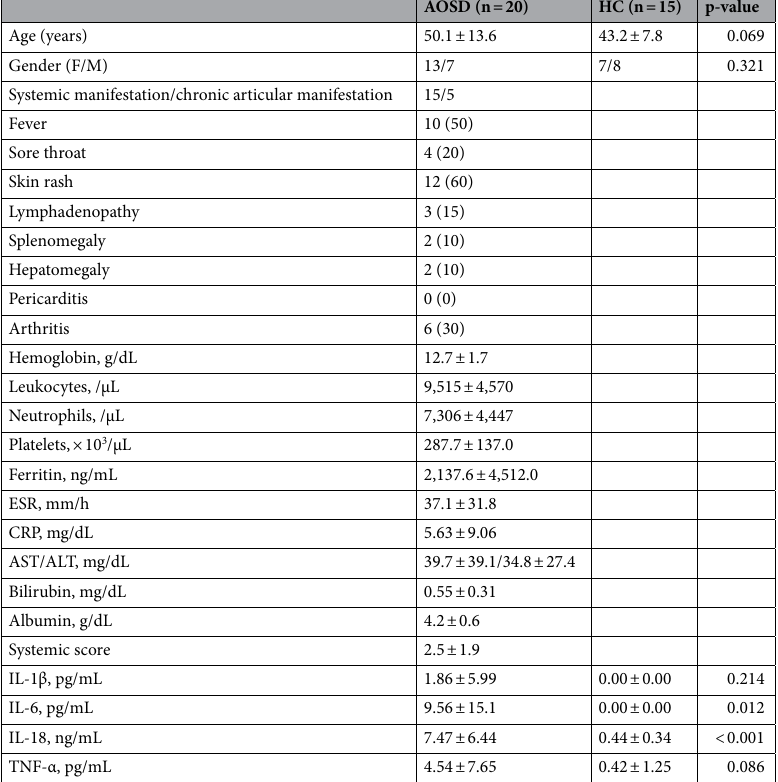
Table 1. Clinical characteristics of patients. AOSD, adult-onset Still’s disease; HC, healthy control; ESR, erythrocyte sedimentation rate; CRP, C-reactive protein; AST, aspartate transaminase; ALT, alanine transaminase; IL, interleukin; TNF, tumor necrosis factor. All values are presented as numbers (with percentages) or means ± standard deviations. The systemic scoring system of Pouchot et al. 40 assigns a score from 0 to 12 with 1 point for each of the following manifestations: fever, typical rash, pleuritis, pneumonia, pericarditis, hepatomegaly or abnormal liver function test data, splenomegaly, lymphadenopathy, leukocytosis ≥ 15,000/mm 2 , sore throat, myalgia, and abdominal pain. These data were assessed using a Mann– Whitney U test or Fisher’s Exact